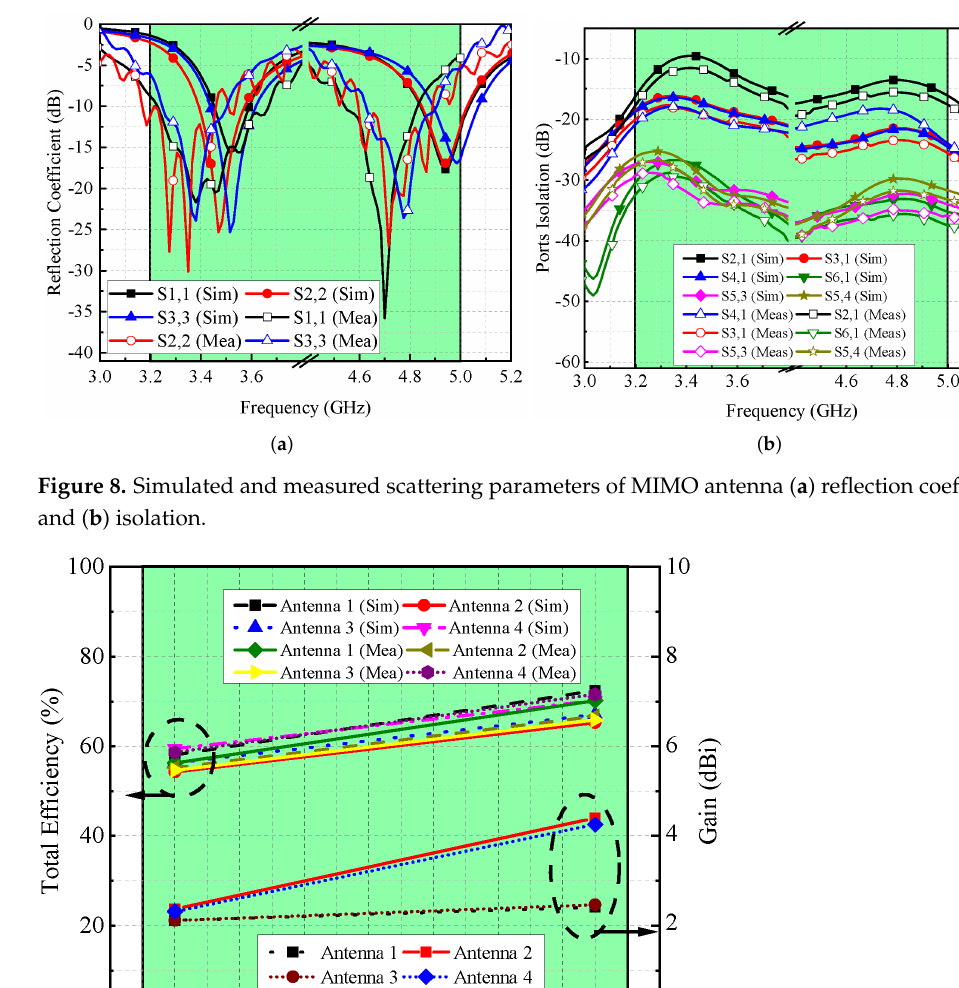
( d ) Figure 7. Fabricated prototype of MIMO antenna (a) front-view and (b) back-view, (c, d) antenna far-field measurement setup. in Figure 8b. It is observed that the isolation performance lies in the acceptable range